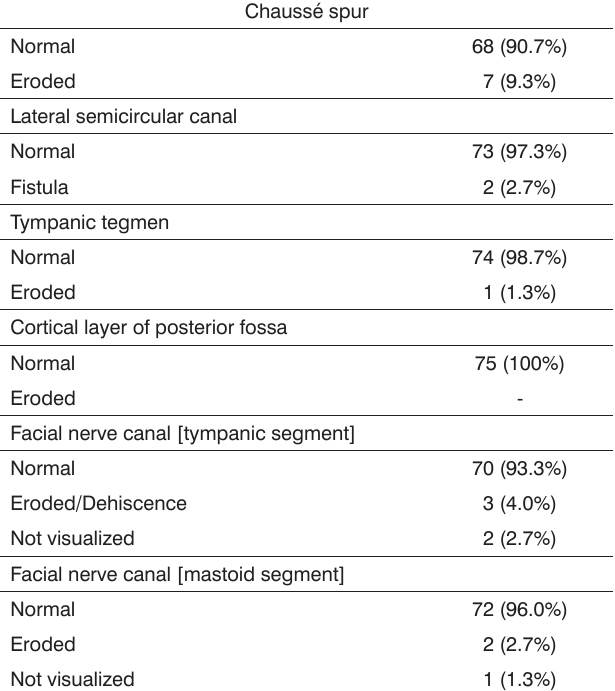
Table 4. Radiological signs of complications in the temporal bone of the contralateral ear.